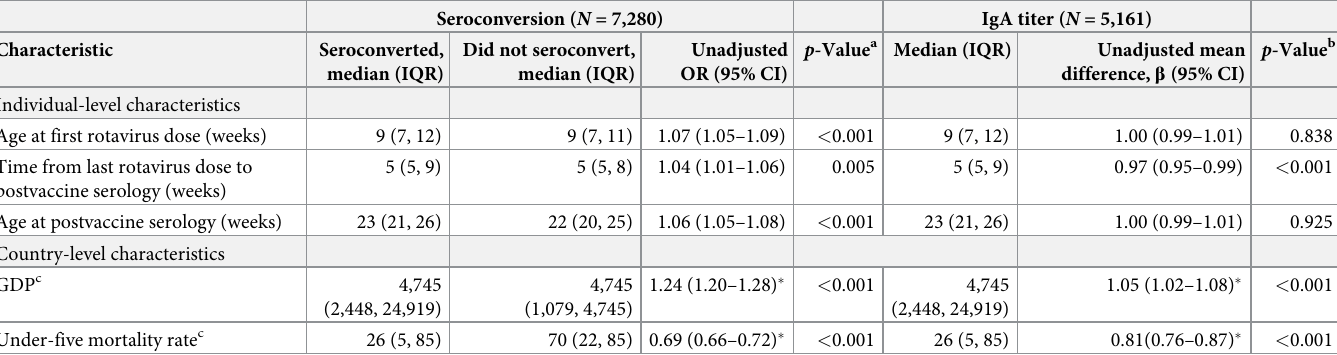
Table 5. Continuous individual- and country-level characteristics by antirotavirus IgA seroconversion and antirotavirus IgA titer outcomes.